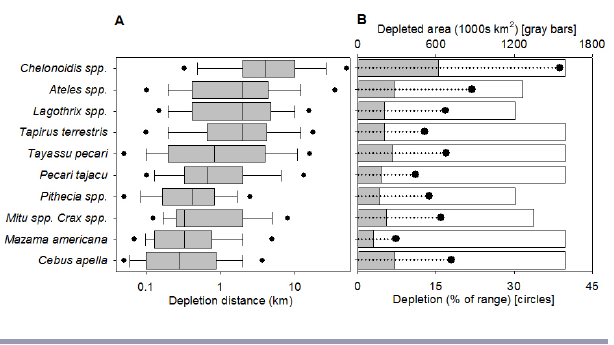
Fig. 2 . (A) Boxplots of depletion distances around settlements, with 95th percentiles. (B) Percentage of geographic range (filled circles) within the State of Amazonas estimated to be completely depleted of each species and the absolute range area estimated to be either depleted (filled bars) and occupied (empty